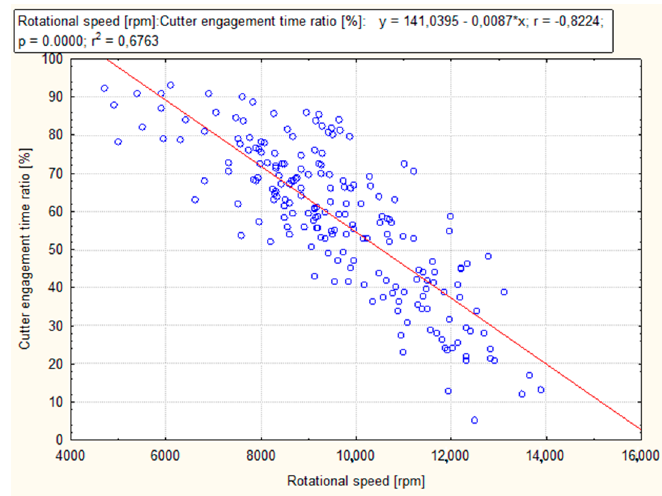
Figure 10. Relationship between the cutter engagement time ratio and the rotational speed of the chainsaw engine.